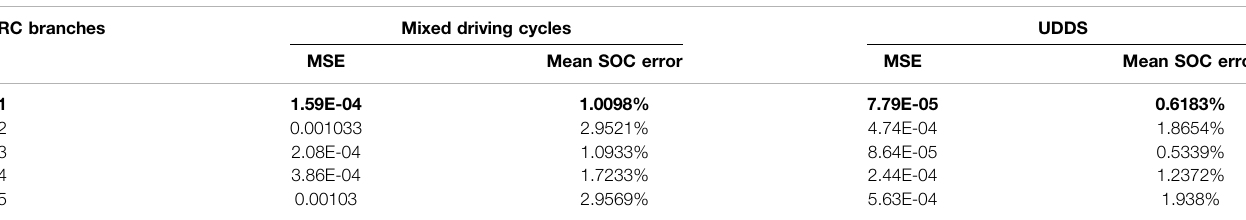
TABLE 19 | Augmented ECM-based H-in fi nity with 5% bias.